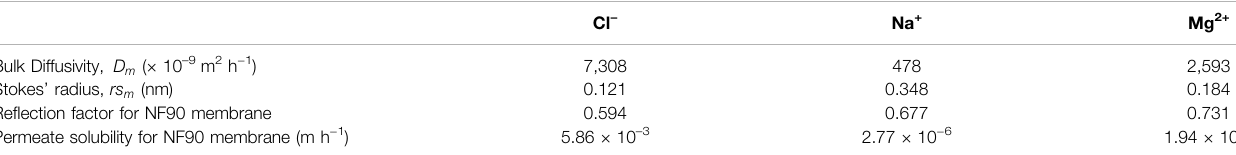
TABLE 3 | Solute properties for illustrative example.